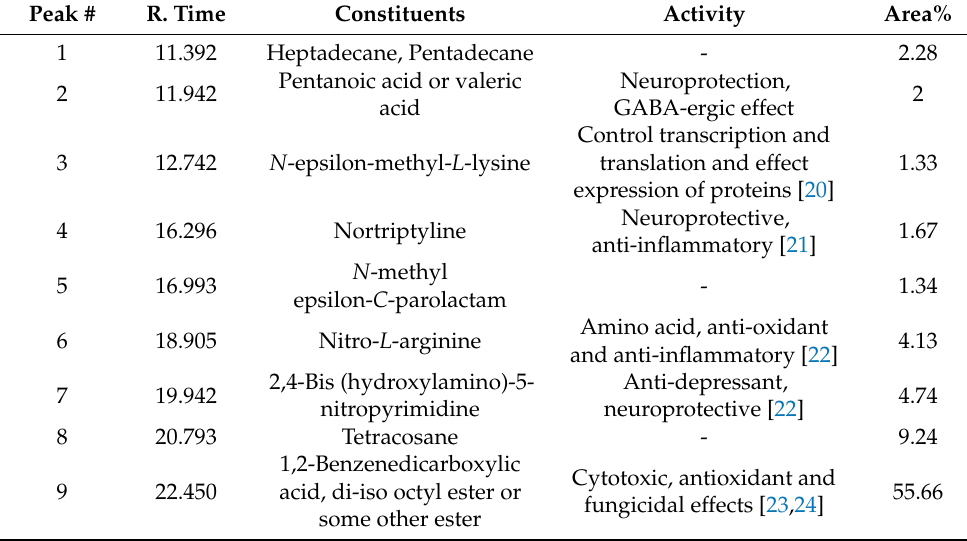
Table 2. Compounds detected through GC-MS analysis. Peak